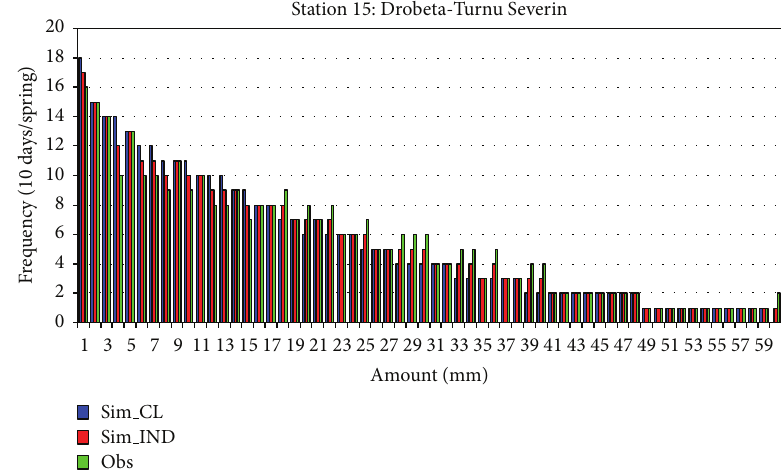
Figure 1: The histogram of the observed spring daily precipitation amount (total over 10 days) and simulated precipitation, considering spatial independence (IND) and dependence (CL) for Drobeta-Turnu Severin